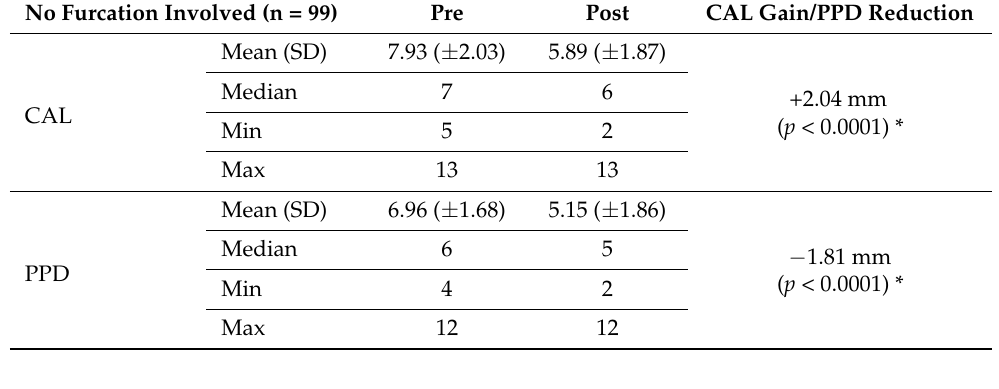
Table 3. Descriptive statistics of PPD and CAL development in sites without furcation involvement after combined chloramine and xHya treatment. Pre = baseline, Post = 6 months post treatment, * = Wilcoxon signed-rank test.